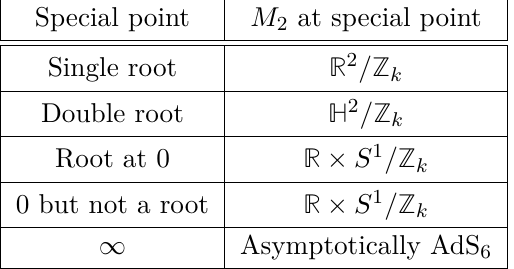
Table 1 . The various choices of end-points for the global completion of the metric on M 2 . The roots at 0 or an end-point at 0 without being a root both lead to singularities in the six-dimensional metric, these can be interpreted as smeared branes. For the final choice the metric on AdS 4 × M 2 becomes asymptotically locally AdS 6